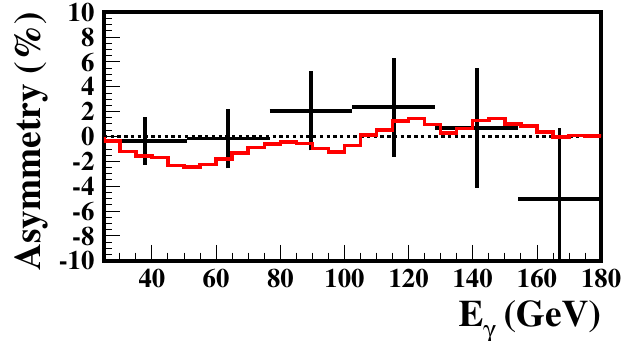
FIG. 26. (Color) Analyzing power R with the aligned diamond crystal as a function of the photon energy E ideal photon beam without angular divergence and (red curve) for the Monte Carlo simulation of photons with the beam conditions in the actual experiment.